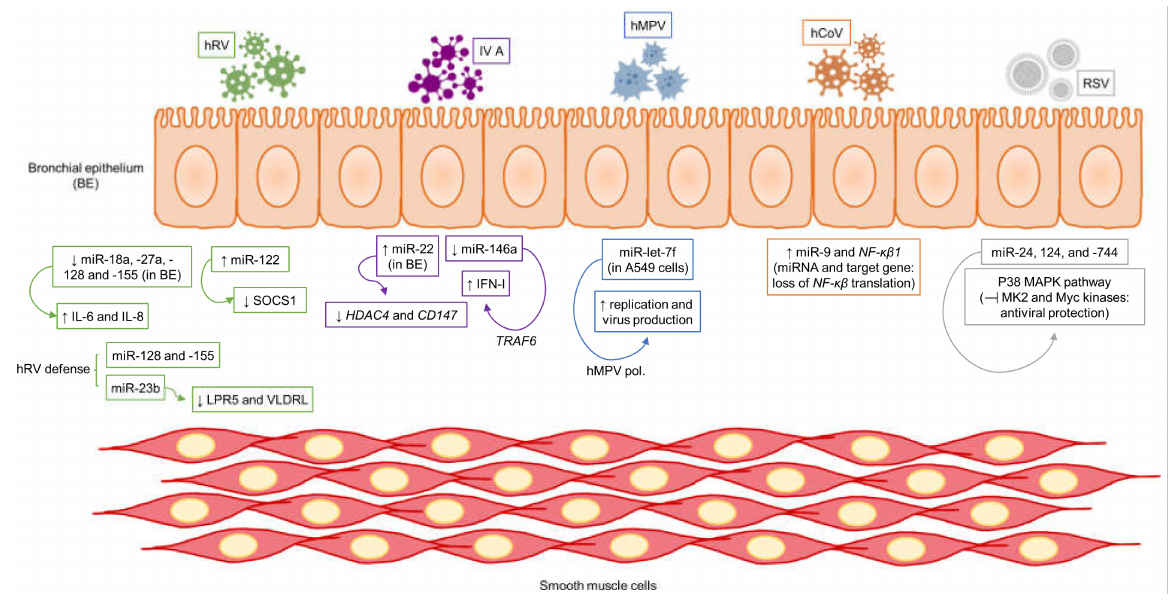
Figure 2. miRNAs are involved in virally induced asthma exacerbations. Several studies have shown the role of miRNAs in different mechanisms of viral exacerbations in asthma, most of which have sought to unravel how miRNAs control responses against the specific virus or how the virus interacts with host cells. Findings from this research reveal that miRNAs modulate antiviral immune responses, control virus replication, and determine how immune cytokine responses are orchestrated or regulated against respiratory viruses including human rhinovirus (hRV), influenza virus (IV), human metapneumovirus (hMPV), human coronavirus (hCoV), and respiratory syncytial virus (RSV). Sharp arrows indicate relationship or causation while blunt arrows signal